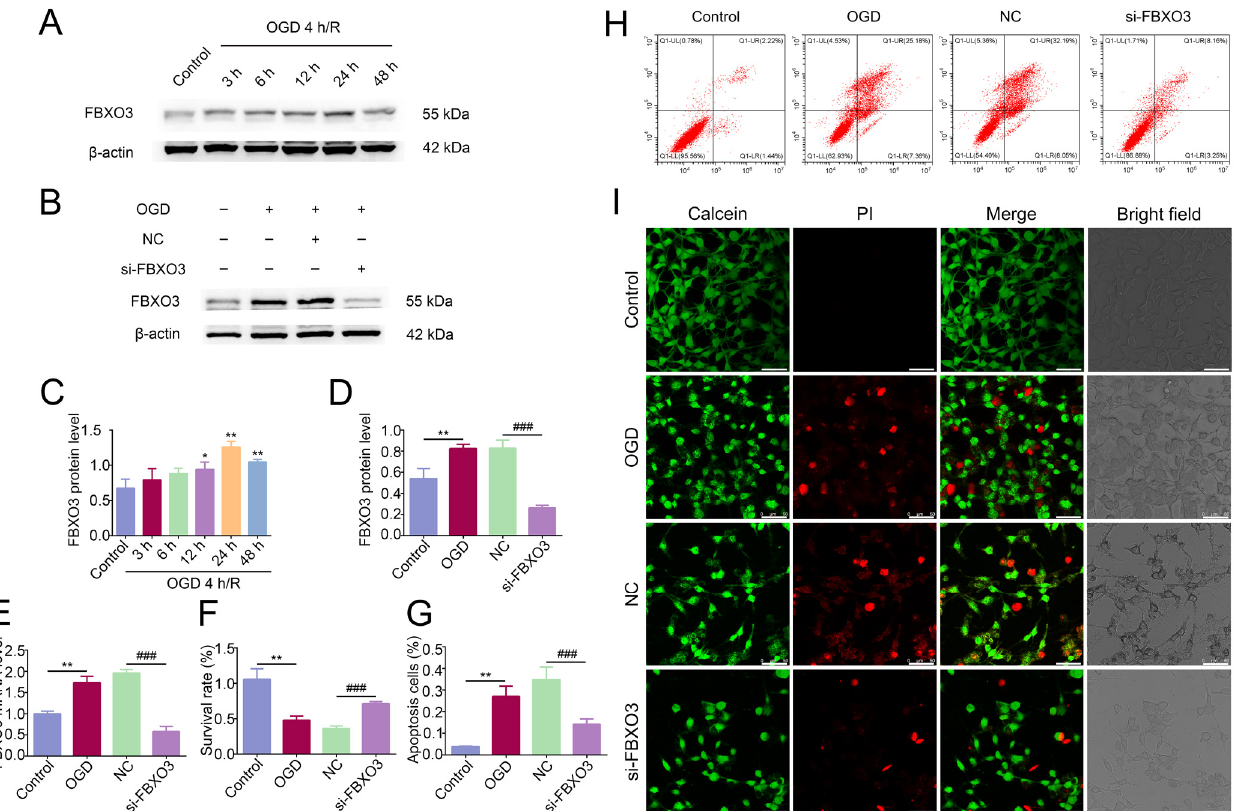
Figure 3. Interference of FBXO3 attenuated the glucose deprivation/reoxygenation (OGD/R) in ‐ duced neuronal death in vitro. ( A , C ) WB analysis of FBXO3 in HT22 cells at OGD 4 h/R 3, 6, 12, 24, and 48 h. ( B – E ) WB and qPCR analysis of FBXO3 in HT22 cells at OGD 4 h/R 24 h with or without siRNA treatment. ( F ) CCK8 assays of HT22 cells at OGD 4 h/R 24 h with or without siRNA treat ‐ ment. ( G – H ) Quantification and representative images of Flowcytometry by detecting the fluores ‐ cent intensity of Annexin V ‐ FITC and Propidium Iodide (PI) of HT22 cells at OGD 4 h/R 24 h with or without siRNA treatment. ( I ) Representative immunofluorescence images (×400, scale bar = 50 μ m) of Calcein and PI in HT22 cells at OGD 4 h/R 24 h with or without siRNA treatment. Statistics for each group are expressed as mean ± SD ( n ≥ 6). * p < 0.05, ** p < 0.01 (values in Control group versus different reoxygenation time group), ### p < 0.001 (values in NC group versus si ‐ FBXO3 group).